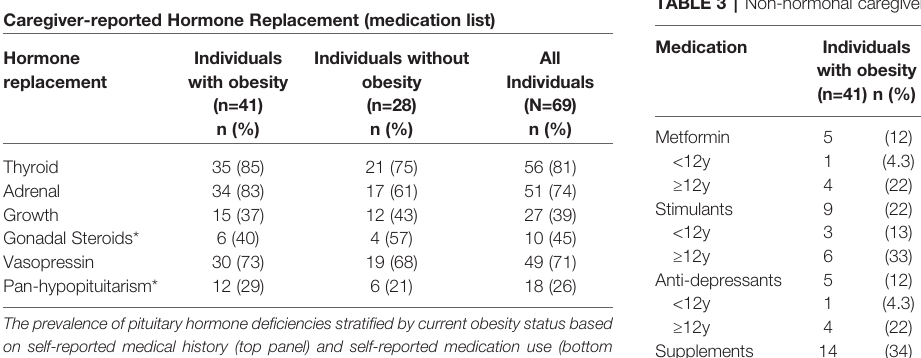
TABLE 3 | Non-hormonal caregiver-reported medications of